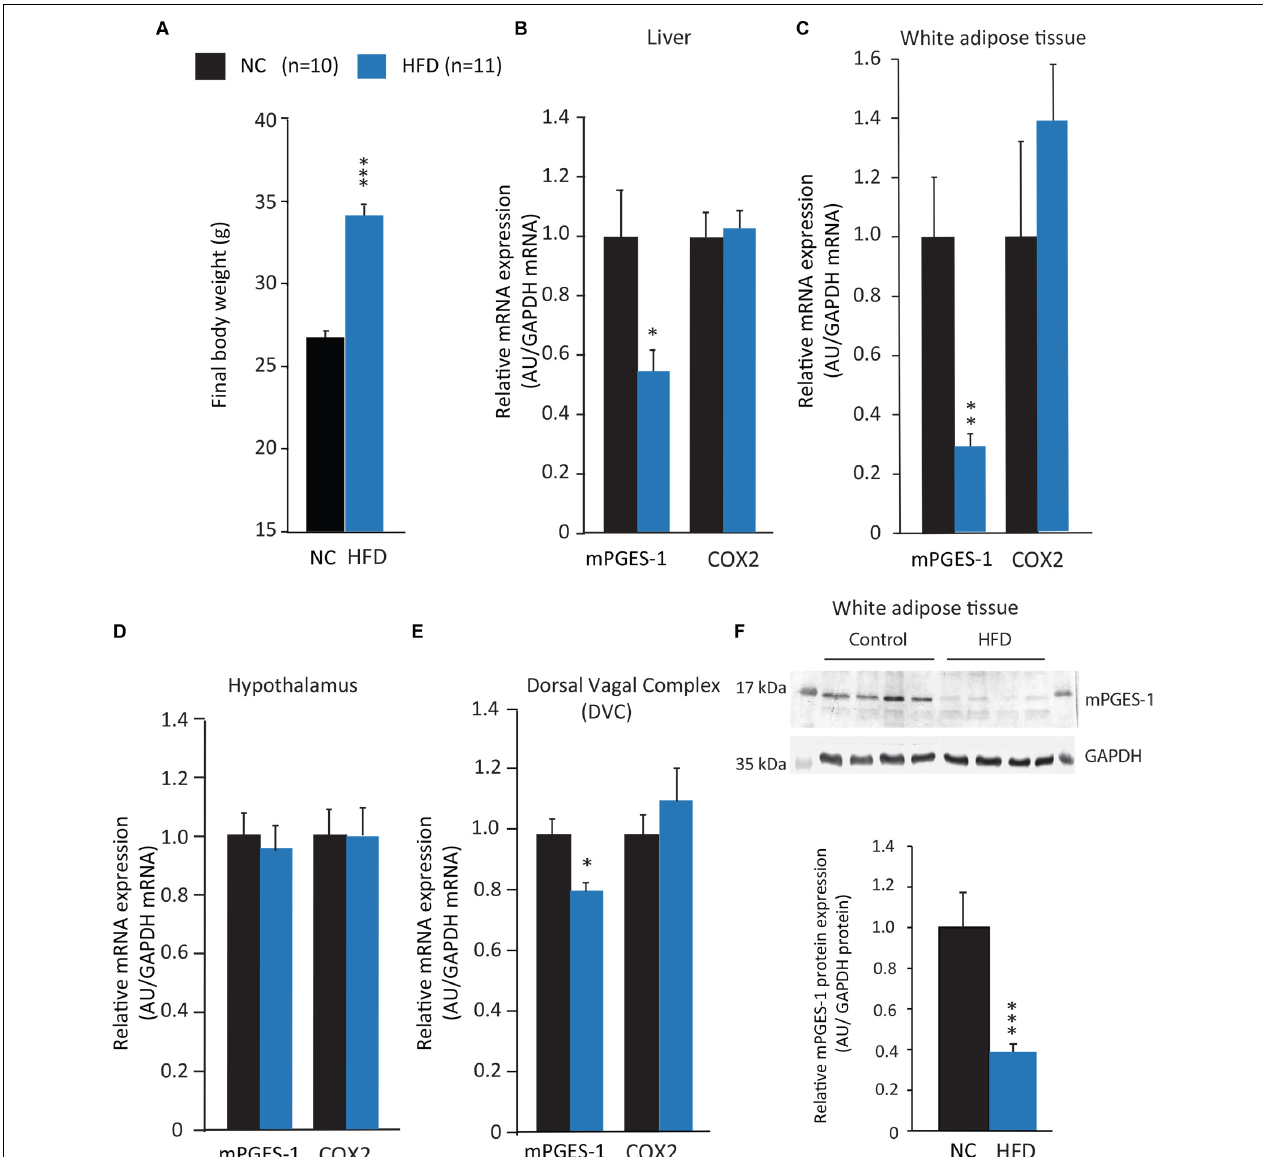
FIGURE 1 | mPGES-1 expression is reduced in diet-induced obesity model. (A) Final BW (g) of C57BL/6 mice fed with either normal chow (NC) or a high-fat diet (HFD) for 10 weeks. (B–E) Real-time PCR analysis of mPGES-1 and COX-2 mRNA expression in the liver (B) , white adipose tissue (C) , hypothalamus (D) and brainstem (E) in NC- and HFD-fed mice. (F) Western blot analysis of mPGES-1 expression within the white adipose tissue of NC- and HFD-fed mice. First and last lanes: 17 kDa weight ladder. Data shown are mean ± SEM; ∗ , significantly different from NC; ∗ p < 0.05; ∗∗ p < 0.01; and ∗∗∗ p <